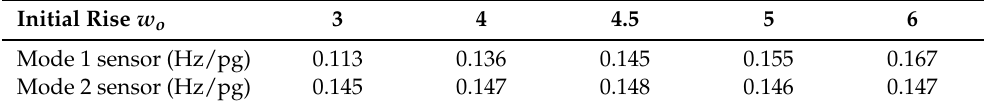
Table 5. Responsivity of arch microbeam sensors with an initial rise of w o = 6µm based on the shift in the resonant peak of modes 1 and 2 and operating under a waveform with RMS voltage of V RMS = 15V.